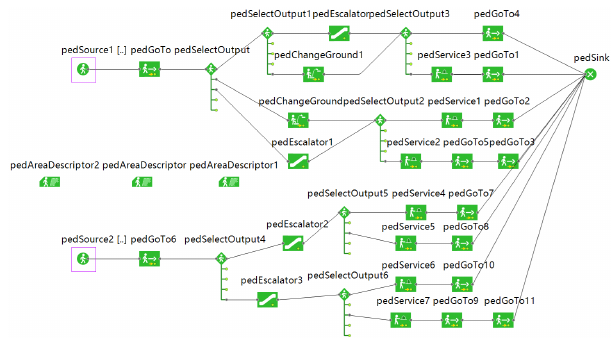
Figure 8. Background operation logic of pedestrian evacuation.